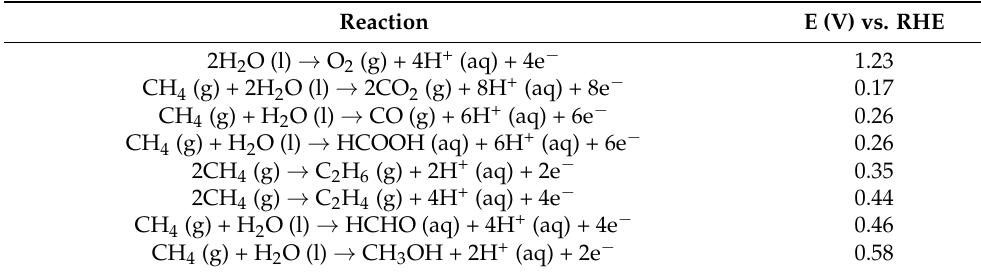
Figure 4. Solid/liquid junction at the semiconductor/electrolyte interface and band diagram of several semiconductor materials [10]. Table 1. Possible methane oxidation reactions along with standard electrode potentials.